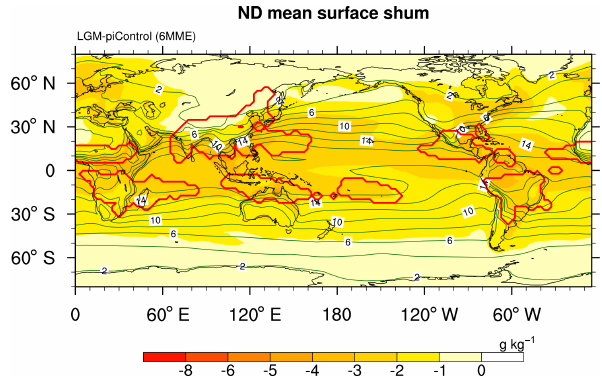
Figure 8. Difference of ND mean surface specific humidity be- tween LGME and piControl (shaded). The green contours denote the climatology derived from piControl. The red lines enclose the monsoon domains. Only those areas where the signal-to-noise ratio exceeds 1 are